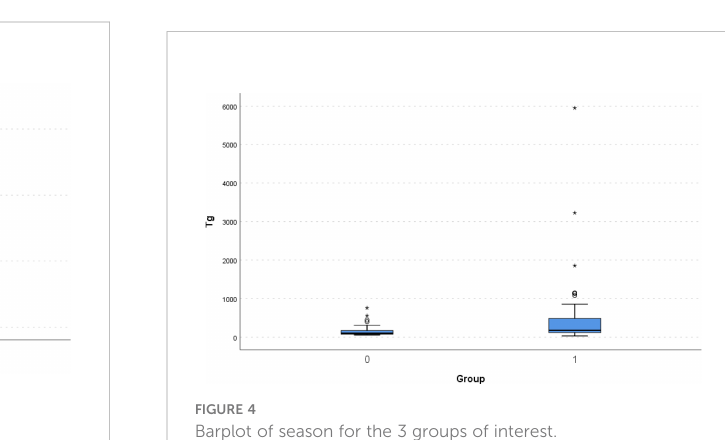
FIGURE 3 Barplot of season for the 2 groups of interest.